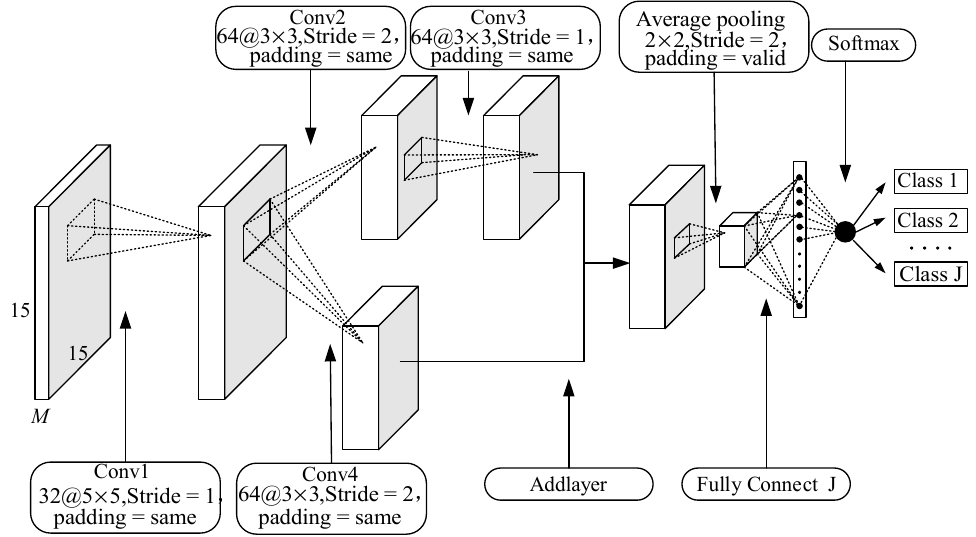
Figure 5. CNN classifier architecture.